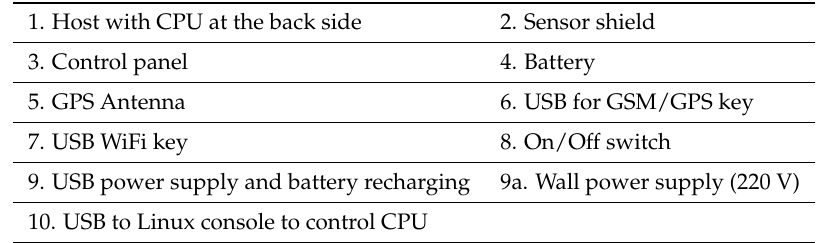
Table 1. Hardware components of